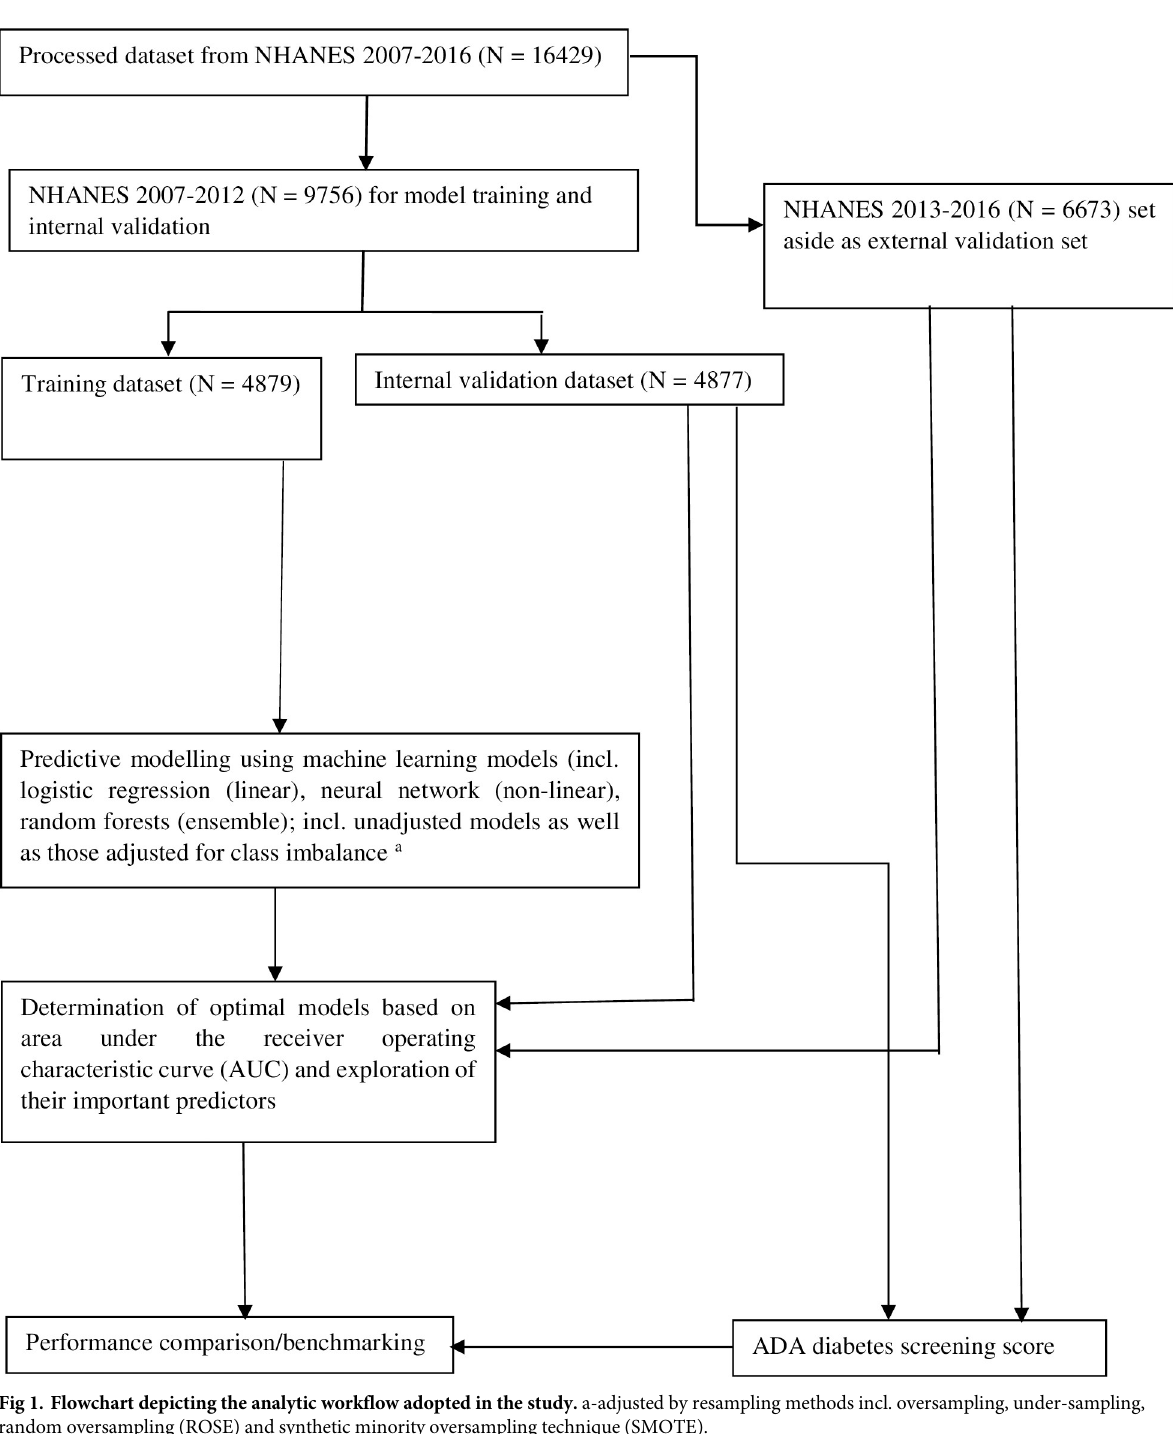
dl] were removed. Since the aim was to elucidate markers of overt type 2 diabetes as opposed to normoglycaemia, individuals with prediabetes according to ADA criteria [HbA1c = 39–47